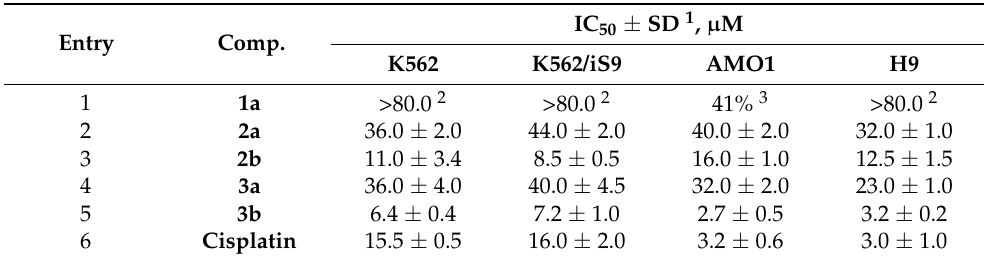
Table 3. Cytotoxicity of the phosphoryl-functionalized amide derivatives against some human hematopoietic c ancer cell